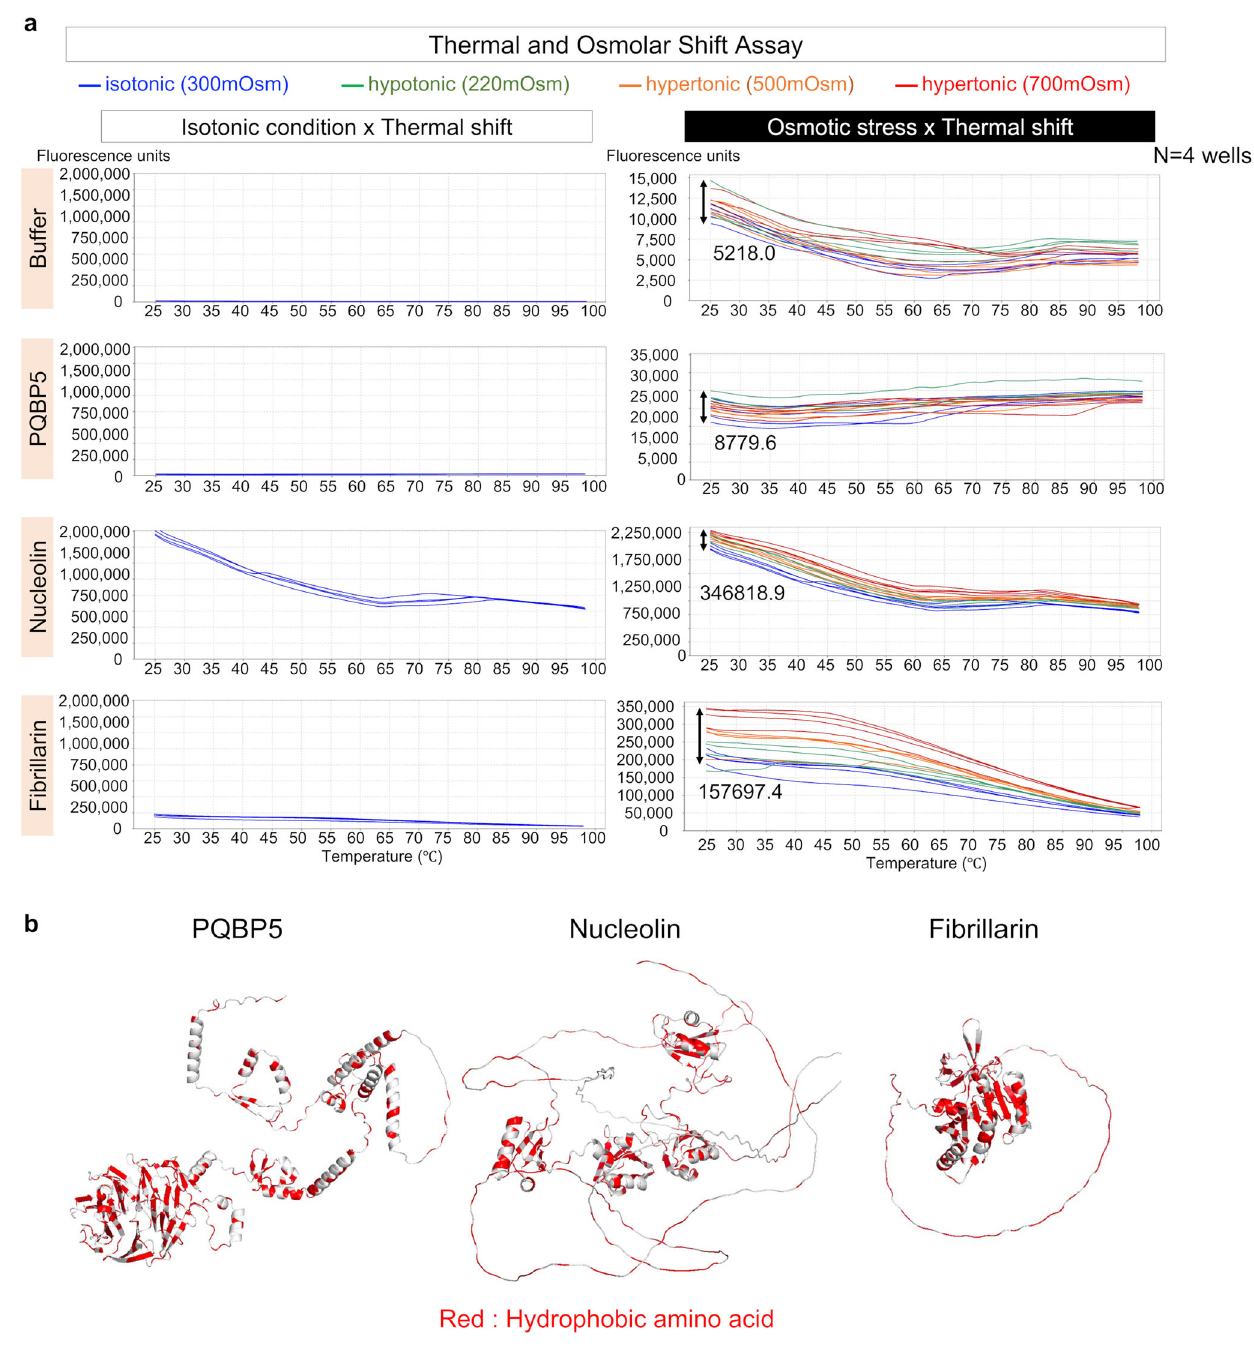
Fig. 5 | Thermal and osmotic shift assays reveal differences in the physico- chemical properties of the three nucleolar proteins. a Thermal shift assay (left panels). Florescence signal intensities of the three nucleolar proteins at an osmo- larity of 300mOsm while changing the temperature from 25°C to 99°C. The fre- quency of exposure of hydrophobic amino acids at the outer surfaces of PQBP5,